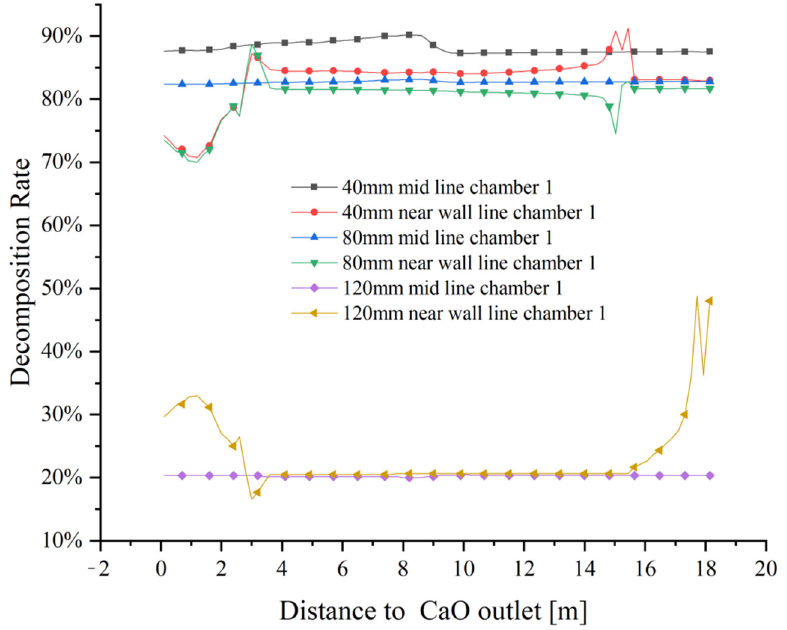
Figure 22. Variation in mid lines and near wall lines decomposition rates at 40 mm, 80 mm and 120 120 mm particle mm particle sizes.